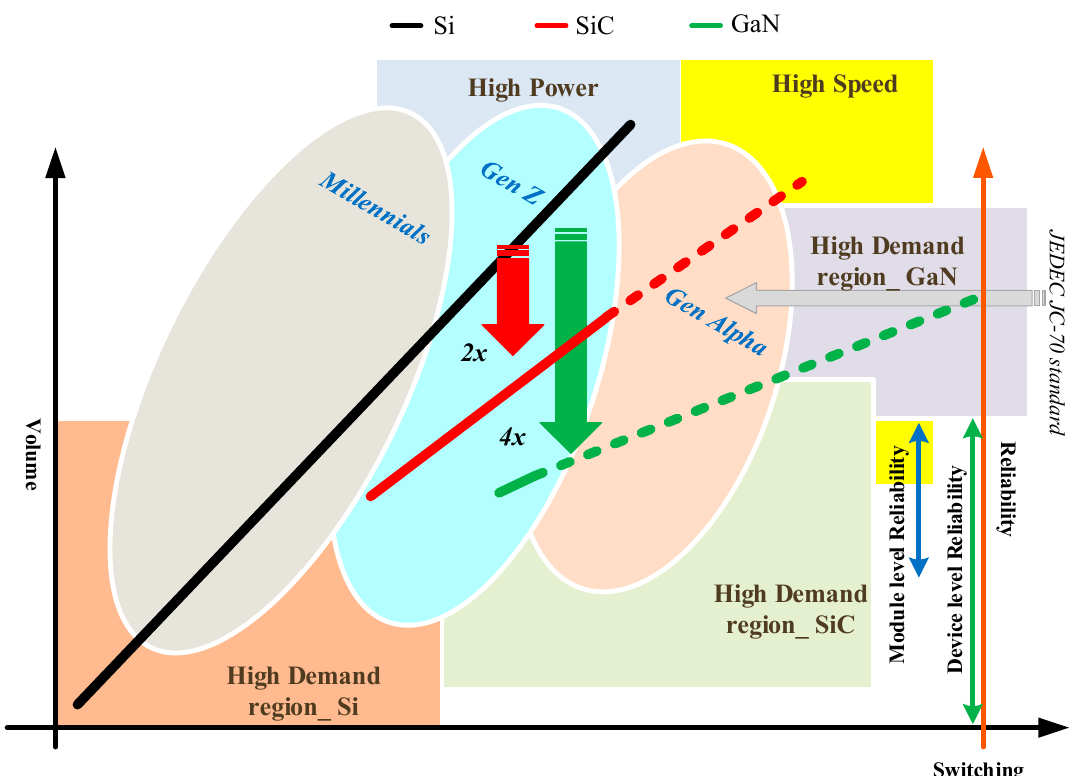
Figure 28 . Comparing WBGSs versus Si with concerning projected demand, volume, frequency, reliability and generation.